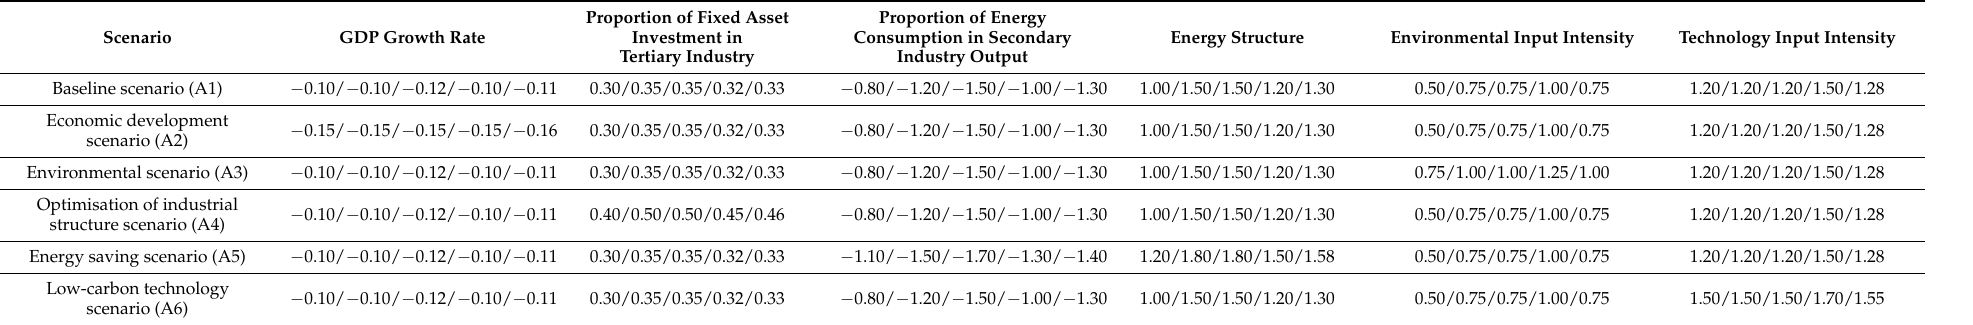
Table 7. Single regulation of carbon emissions scenario parameter